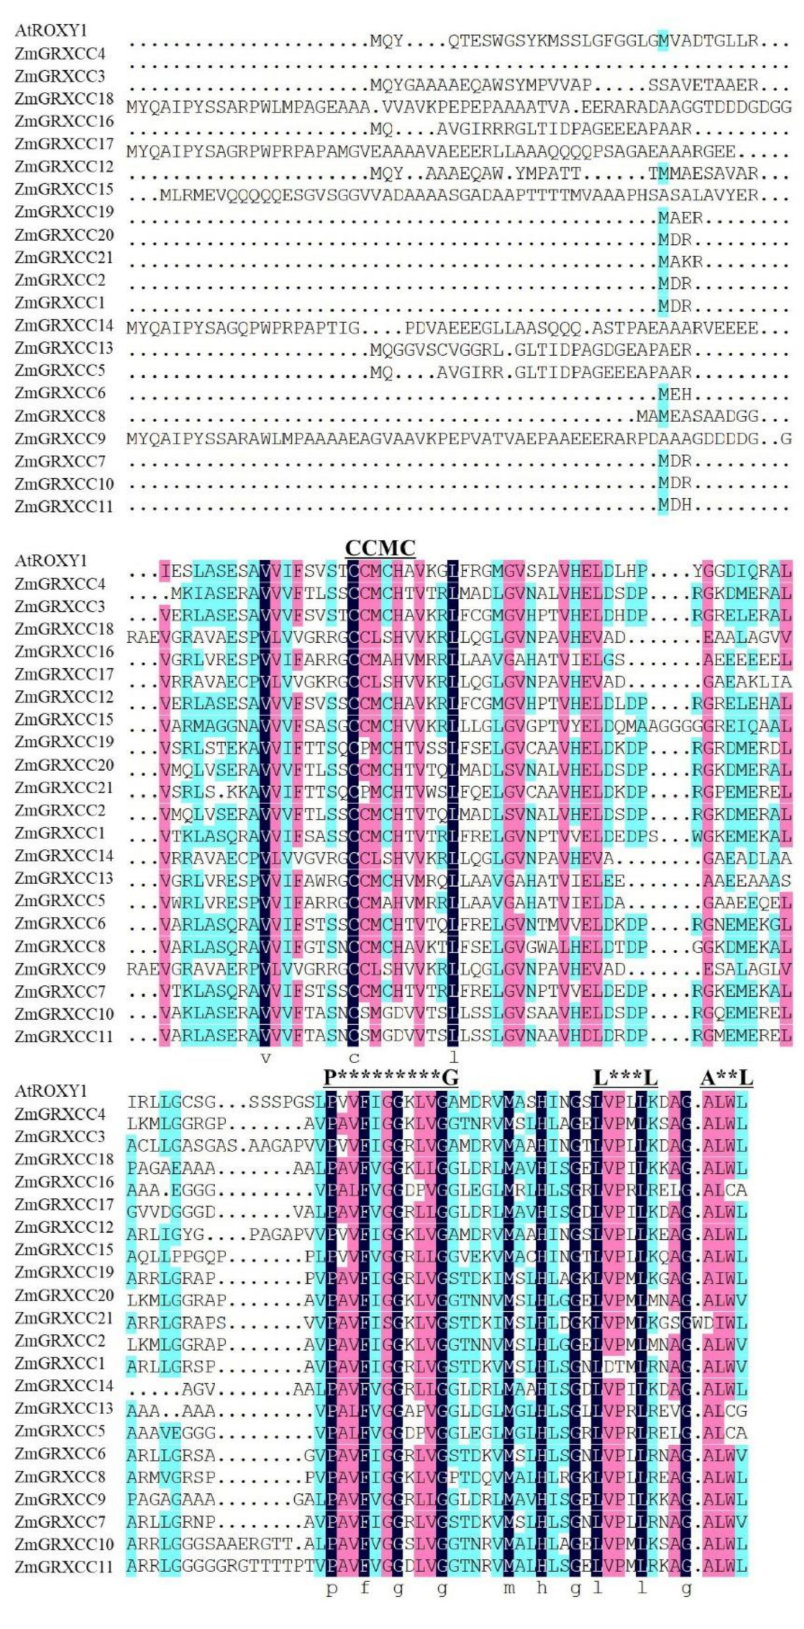
Figure 3. Alignment of ZmGRXCC protein sequences. Black boxes indicate identified conserved positions. The letters above the sequence indicate motif